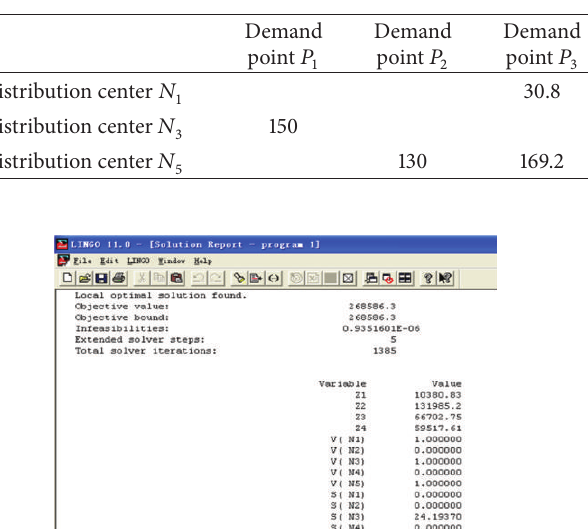
Table 7: The amount that is supplied by distribution centers (t/year).